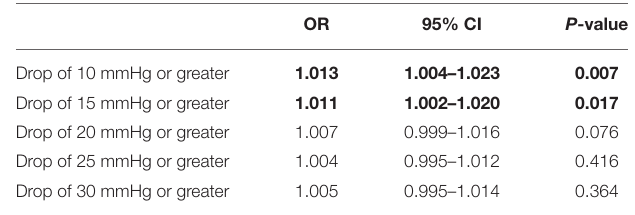
TABLE 2 | Binary logistic regression analyses of associations between duration of MAP drop levels under general anesthesia and poor